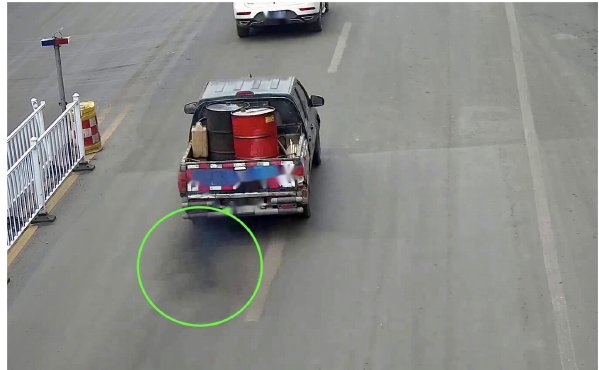
Figure 1. A typical example of vehicle